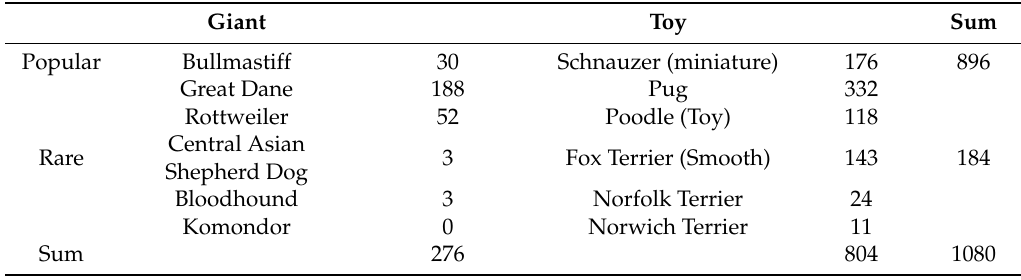
Table 1. The most popular and least popular 12 toy and giant breeds selected for New South Wales (NSW) show results in the current study.